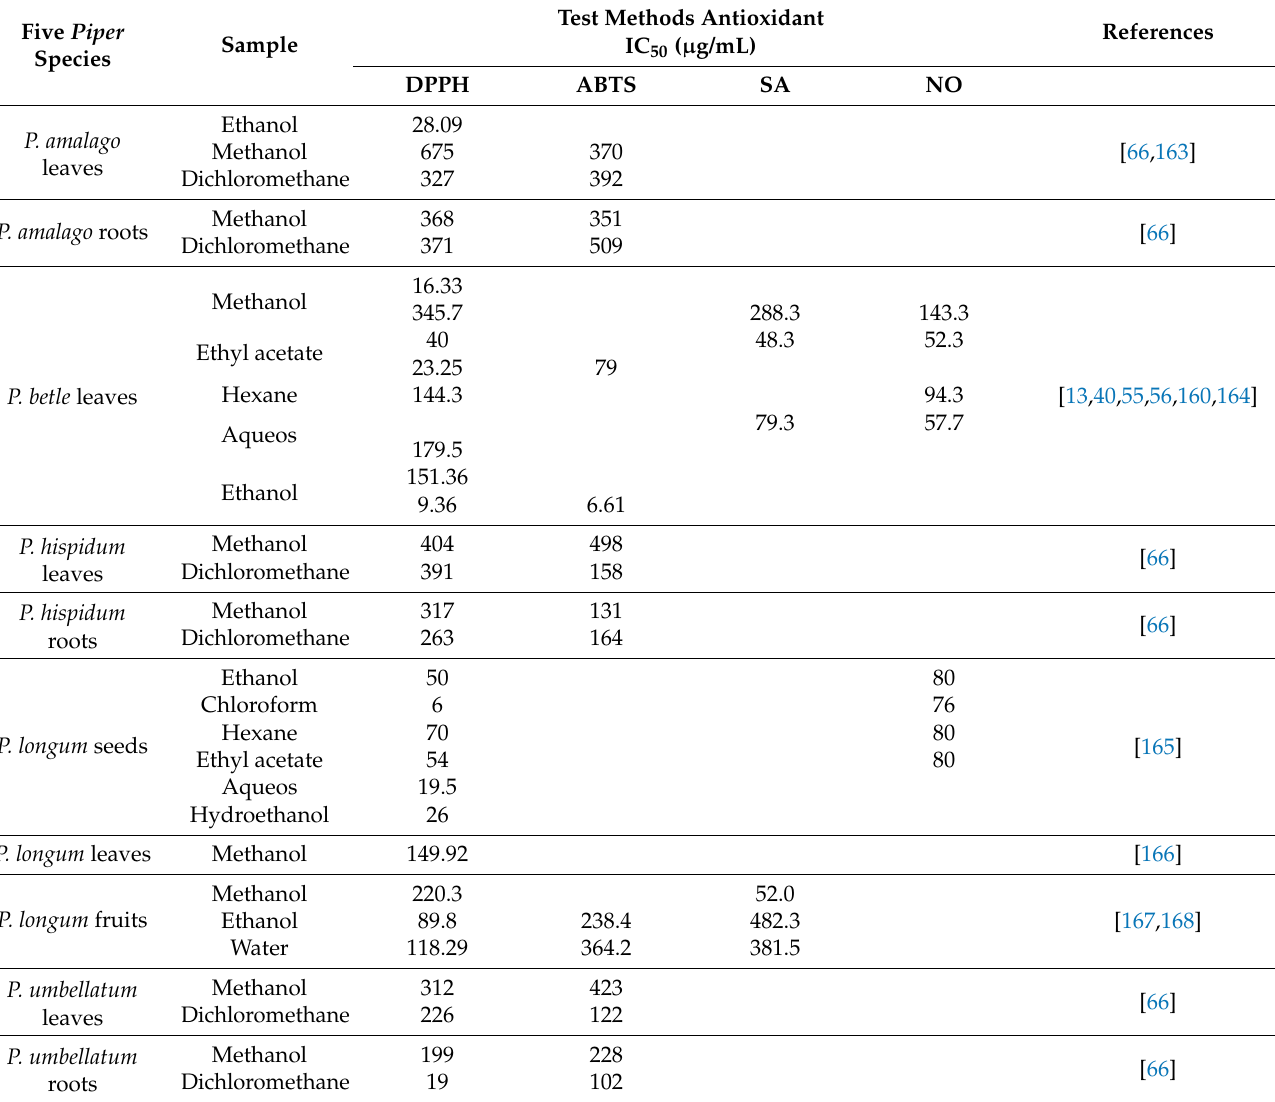
Table 9. Antioxidant activity test using several methods on five Piper